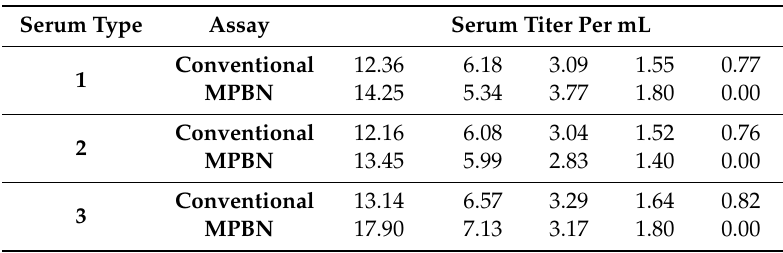
Table 6. Determination of the low limit of titration (LLOT) of anti-poliovirus sera types 1, 2 and 3 by MPBN assay.